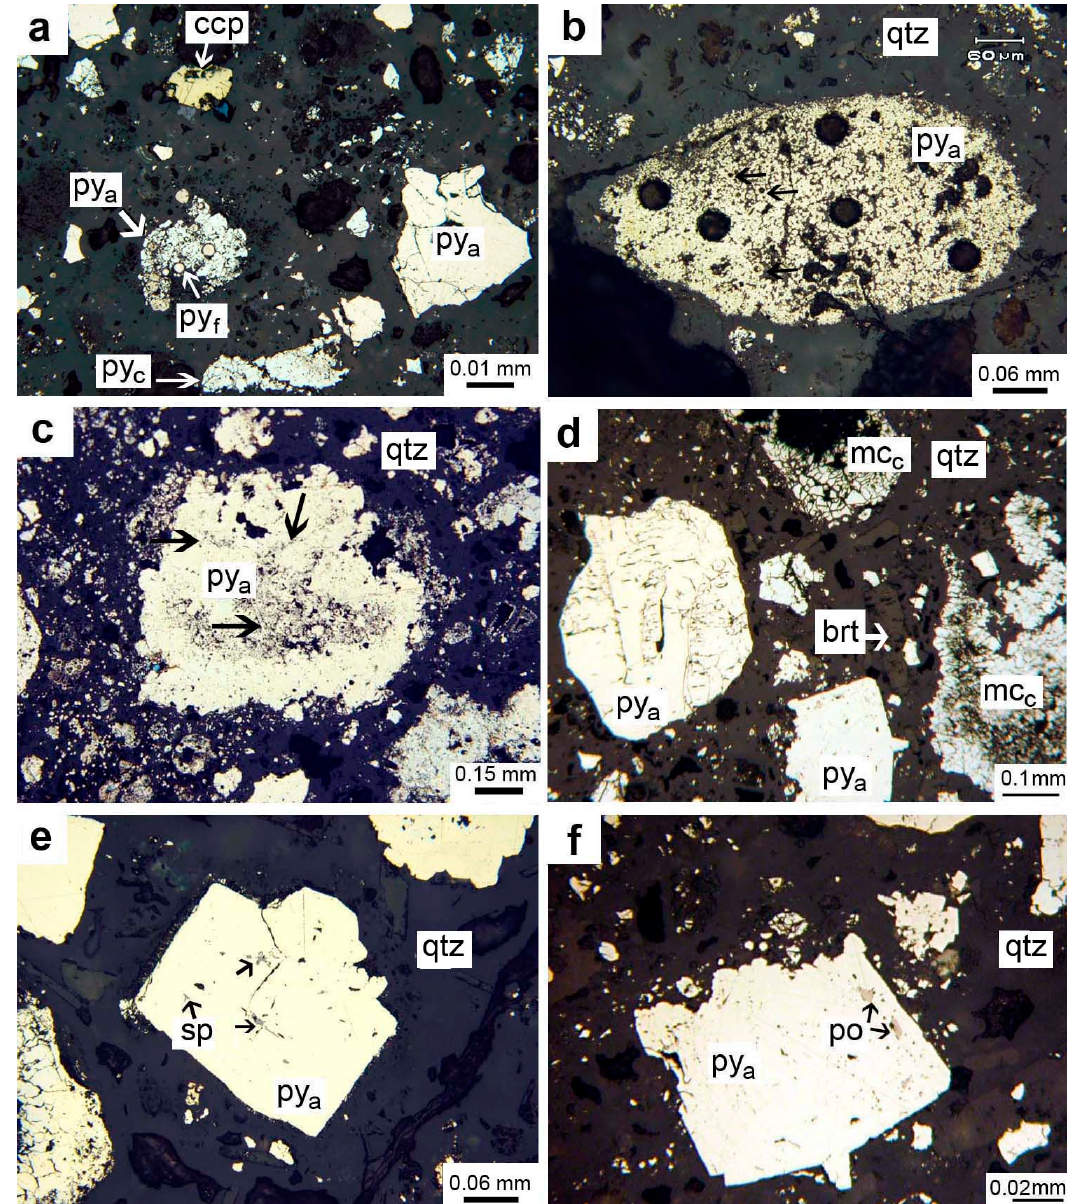
Figure 4. Authigenic forms of pyrite in breccia matrix from the Semenov ‐ 3 hydrothermal field: ( a ) framboidal pyrite (py f ) overgrown by crystalline pyrite; ( b ) ovoid pyrite aggregate with relict framboidal structure (indicated by arrows; black dots are areas of LA ‐ ICP ‐ MS analysis); ( c ) pyrite nodule with porous center and crystalline exterior and inclusions of other sulfides and barite (indicated by arrows); ( d ) pyrite crystals developed after three crystals of barite (left), clasts of marcasite and individual barite crystals in the breccia matrix; ( e ) crystalline pyrite with inclusions of sphalerite; ( f ) crystalline pyrite with inclusions of pyrrhotite. Here and hereafter, ba, barite; sph, sphalerite; po, pyrrhotite. Reflected light.